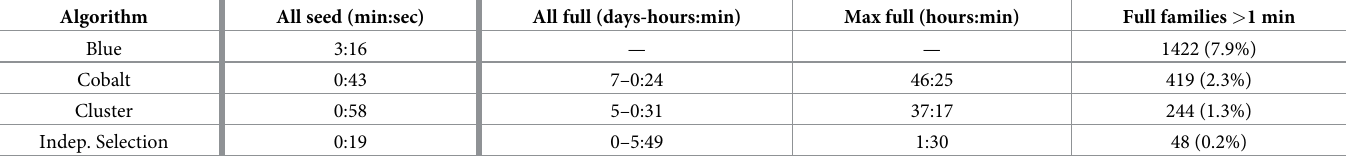
To explore the first hypothesis, we compiled ROC curves for the 708 families split by all four algorithms. Fig 4B shows that the ROC curves for Blue and Cobalt are brought closer to the ROC curve for Independent Selection, and so hypothesis (i) may explain some of the dis- crepancy between the Blue, Cobalt, and Independent Selection benchmarks. However, Table 1. Runtime of implementations on Pfam seed and full. The runtime benchmarks were obtained by running each algorithm on the seed and full multi-MSAs Pfam-A.seed and Pfam-A.full on 2 cores with 8 GB RAM for the seed alignments and on 3 cores with 12 GB RAM for the full alignments. We did not compute the maxi- mum runtime of the Blue algorithm; the algorithm failed to terminate within 6 days for 34